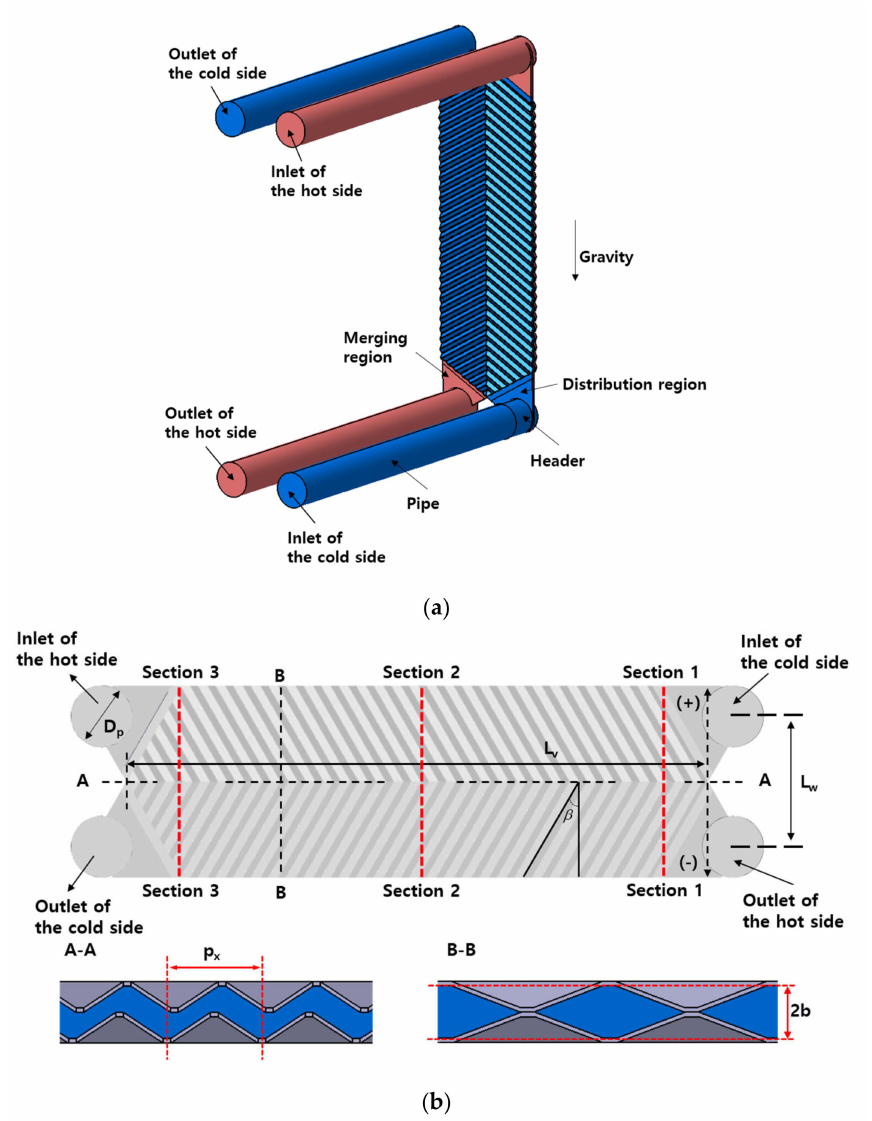
Figure 1. 3D modeling and schematics of the plate heat exchanger (PHX): ( a ) 3D modeling, and ( b ) schematics of